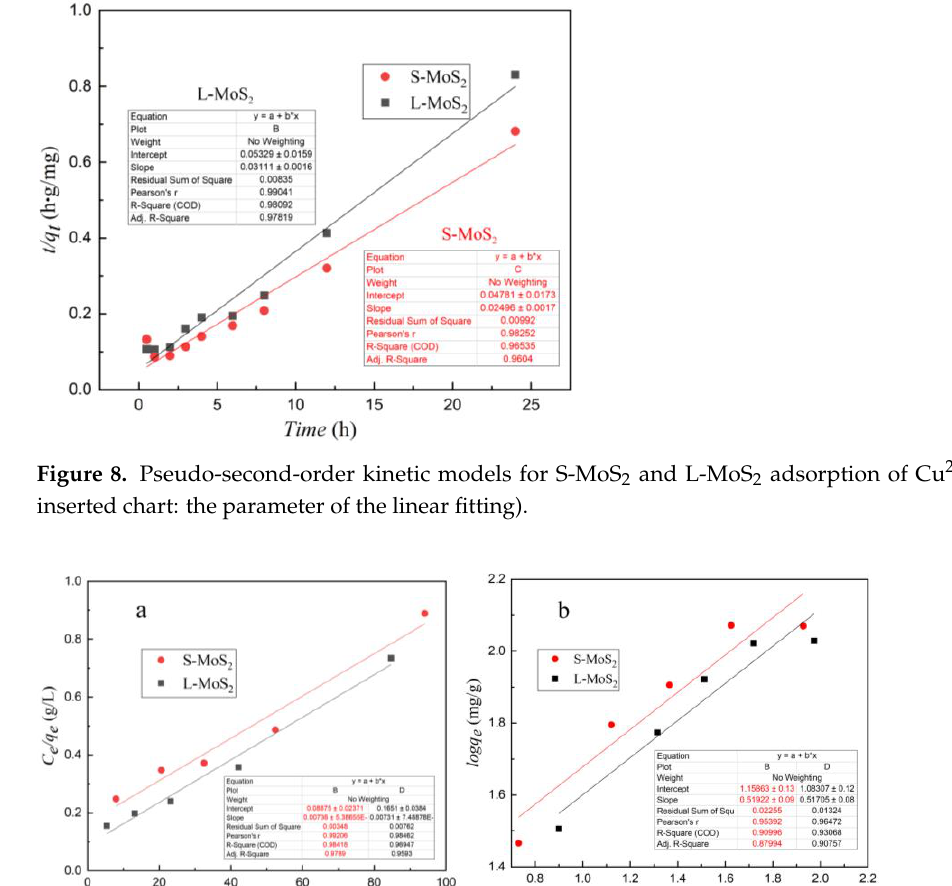
Figure 9. Langmuir ( a ) and Freundlich ( b ) isotherm models fitting Cu 2+ adsorption onto S-MoS 2 and L-MoS 2 (20–100 mg/L) (The inserted chart: the parameter of the linear fitting).